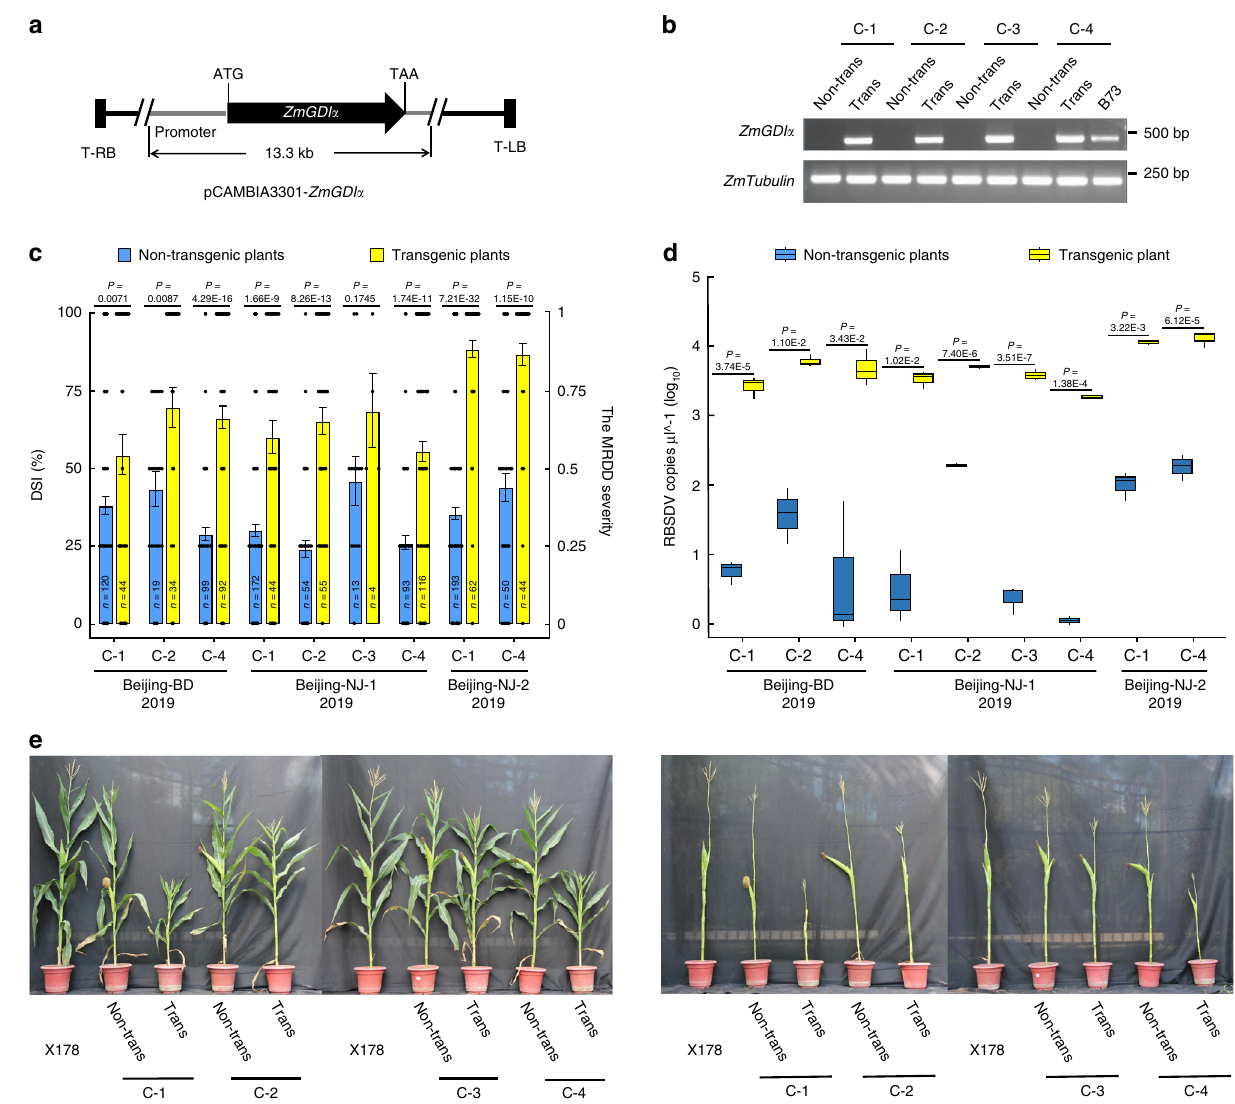
Fig. 2 Functional validation of ZmGDI α via a transgenic approach. a Structure of pCAMBIA3301- ZmGDI α used for the complementation assay. T-RB and T-LB: right and left T-DNA borders, respectively. b Validation of transgenic plants by RT-PCR. The PCR products were observed in T 2 F 1 BC 2 transgenic plants (Trans) but not in non-transgenic siblings (Non-trans). The maize gene ZmTubulin was used as an internal control. The experiment was repeated three times independently, with the similar results. c Disease severity index (DSI) values of T 2 F 1 BC 2 plants. The viruliferous planthoppers reared in Baoding (BD) and Nanjing (NJ-1, NJ-2) were used for arti fi cial inoculation in Beijing. DSI values were estimated for both transgenic and non-transgenic T 2 F 1 BC 2 plants and are denoted as mean ± SEM. The number of plants is indicated in each column. Each dot represents the disease severity of a single plant. d The mean RBSDV copies µ l^-1 (log 10 ) and distribution in T 2 F 1 BC 2 plants. Leaf tissues were sampled three times independently as three biological replicates. Box edges represent quartiles, and the medians were shown with the central line in the boxes. e The resistance performance of T 2 F 1 BC 2 progeny plants. Transgenic plants (Trans) were more susceptible to MRDD than non-transgenic siblings (Non-trans) with stunting plants, shortened internodes, and malformed tassels/ears. The inbred line X178 was used as a resistant control. P -values were estimated by two-tailed Student ’ s t -test. Source data underlying b – e are provided as a Source Data fi (Fig. 3a). Because of this, we performed RT-qPCR assays to quantify the total number of transcripts. At each assay point, gene expression levels were comparable between ZmGDI α and ZmGDI α -hel under either infected or non-infected conditions.